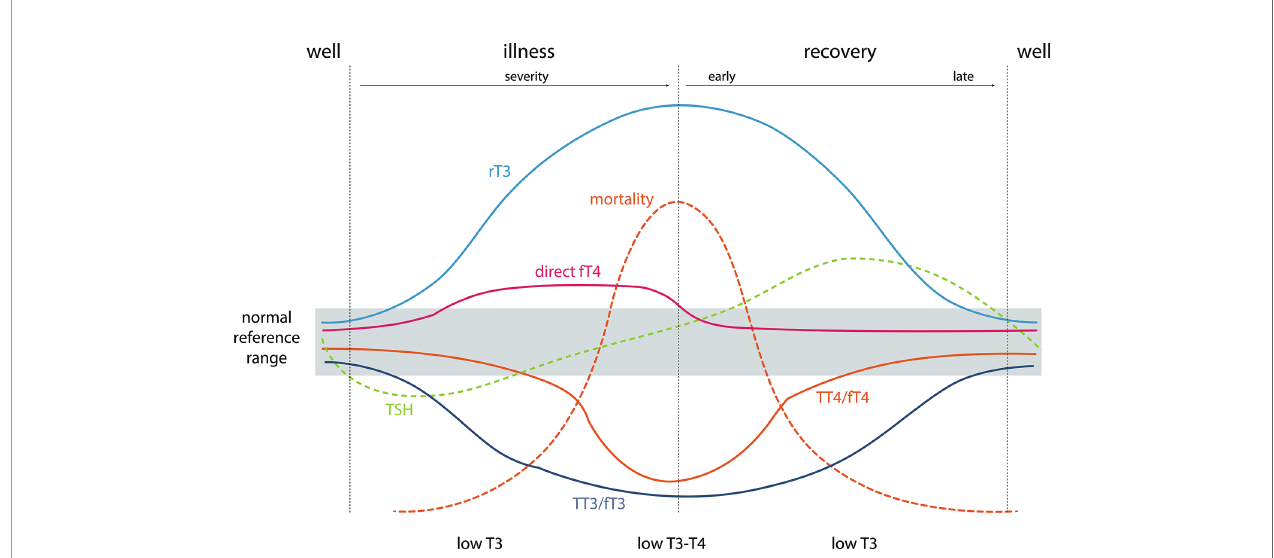
FIGURE 1 | Typical changes in thyroid function tests during the development of and recovery from nonthyroidal illness and their relationship to mortality. TSH, thyrotropin; TT3/TT4, total thyroid hormones; FT3/FT4, measured free thyroid hormone estimates; direct FT4, direct measurement of free T4 by dialysis or